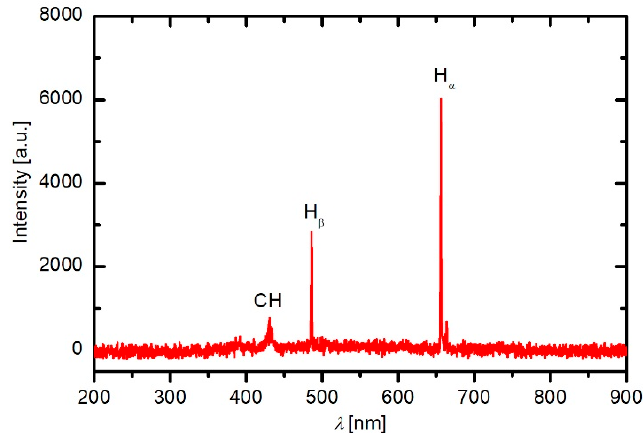
Figure 5. An optical spectrum of gaseous plasma during the deposition phase.